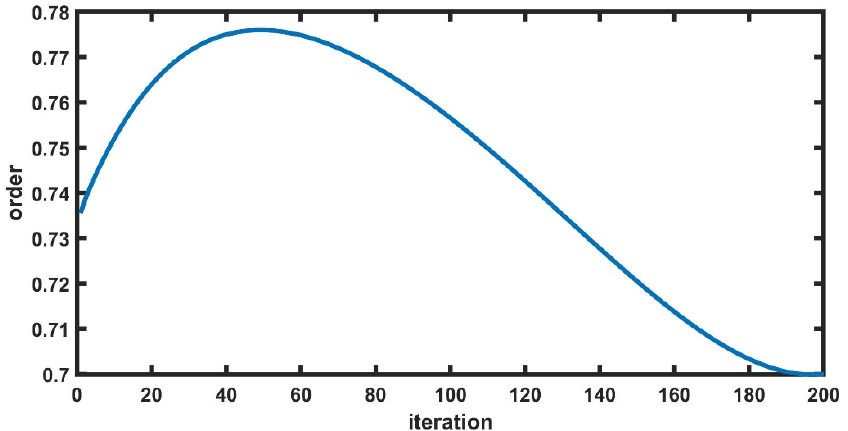
Figure 11. The estimated fractional-order convergence curve.